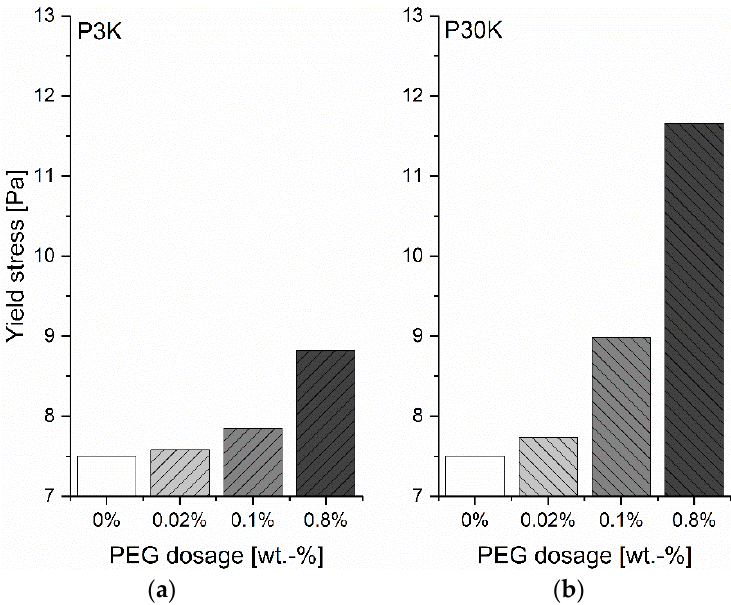
Figure 4. Yield stress of GBS along with the increasing dosages of PEG; ( a ) P3K; ( b ) P30K.